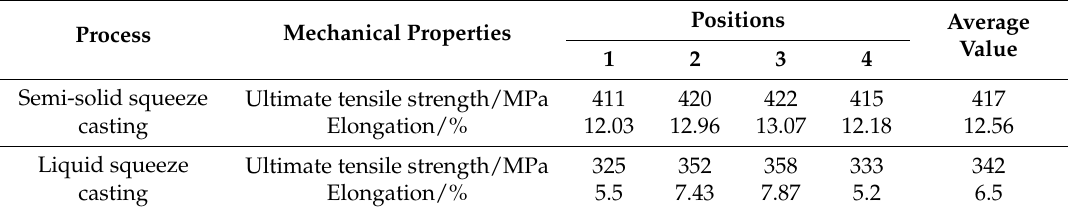
Table 3. Ultimate tensile strengths and elongations of ZCuSn10P1 alloy parts produced by semi-solid squeeze casting and liquid squeeze casting for different